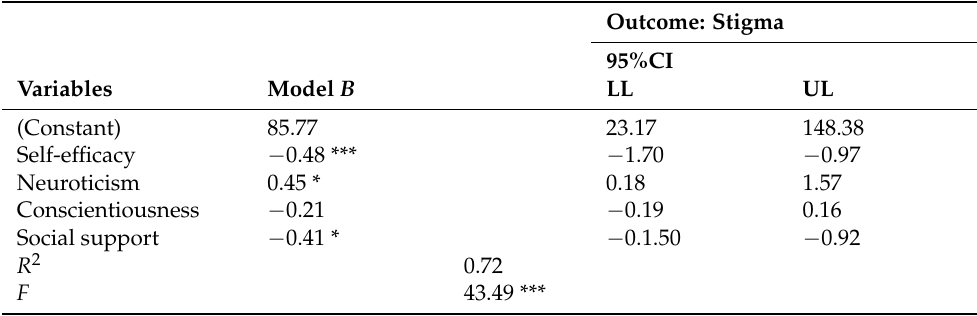
Table 2. Multiple Regression Analysis Showing Impact of Self-Efficacy, Neuroticism, Conscientious- ness and Social Support on Stigma (N = 116).